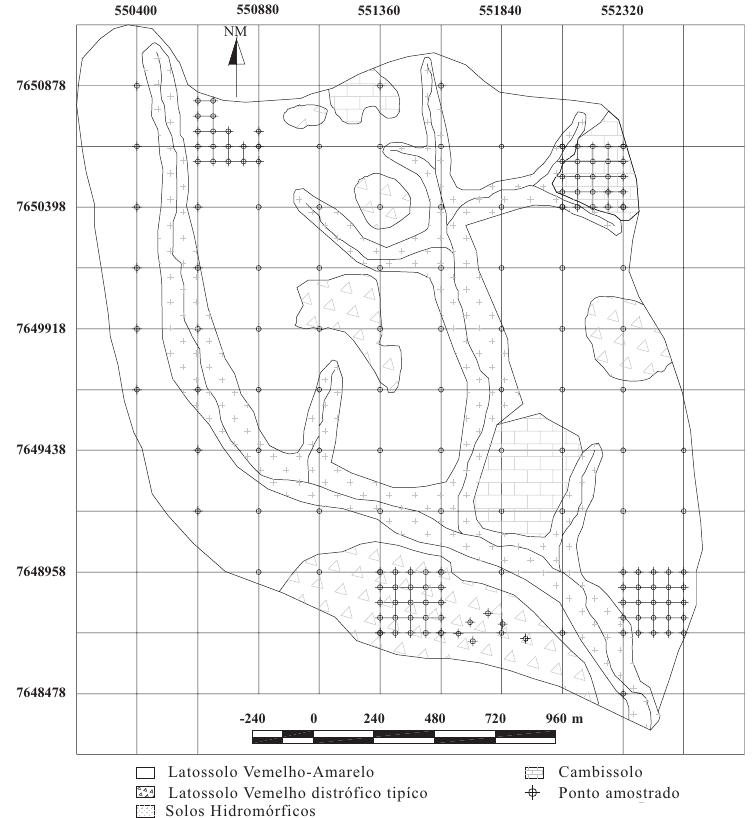
Figura 1. Unidades pedológicas presentes na bacia hidrográfica do Ribeirão Marcela e esquema de amostragem sistemática utilizada nos trabalhos de